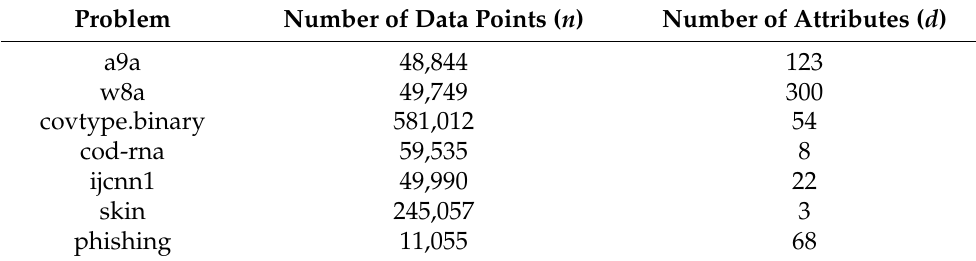
Table 1. Problems